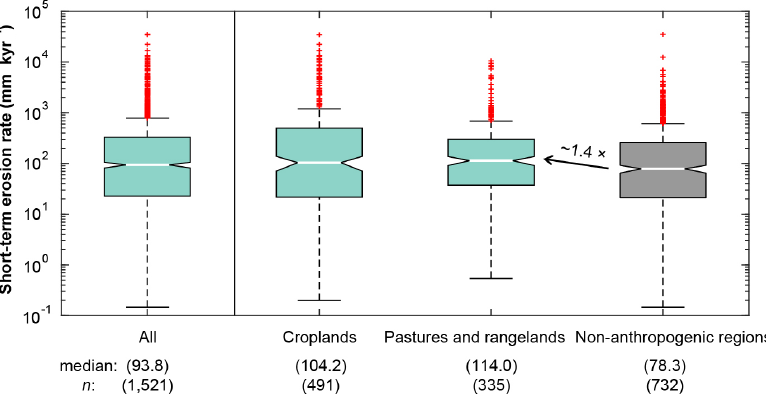
Figure 7. The comparison of global short-term erosion rates with and without anthropogenic influences. The extent of “croplands” and “pastures and rangelands” were digitised from Foley et al. (2005), and here it is shown that short-term erosion rates with anthropogenic influences are ∼ 1.4 times higher than in non-anthropogenically impacted